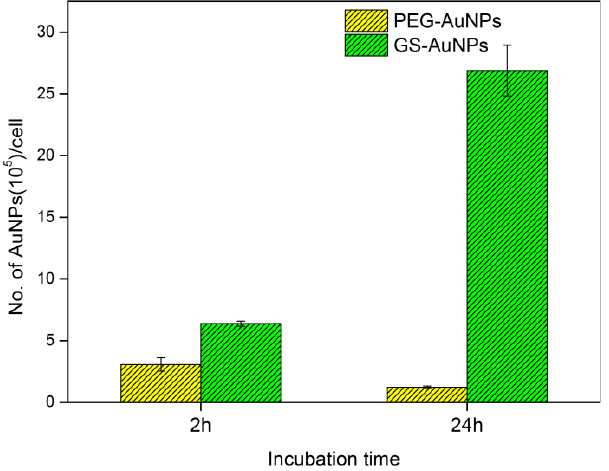
Fig. 4. MCF-7 cells uptake of PEG-AuNPs and GS-AuNPs after 2 h and 24 h